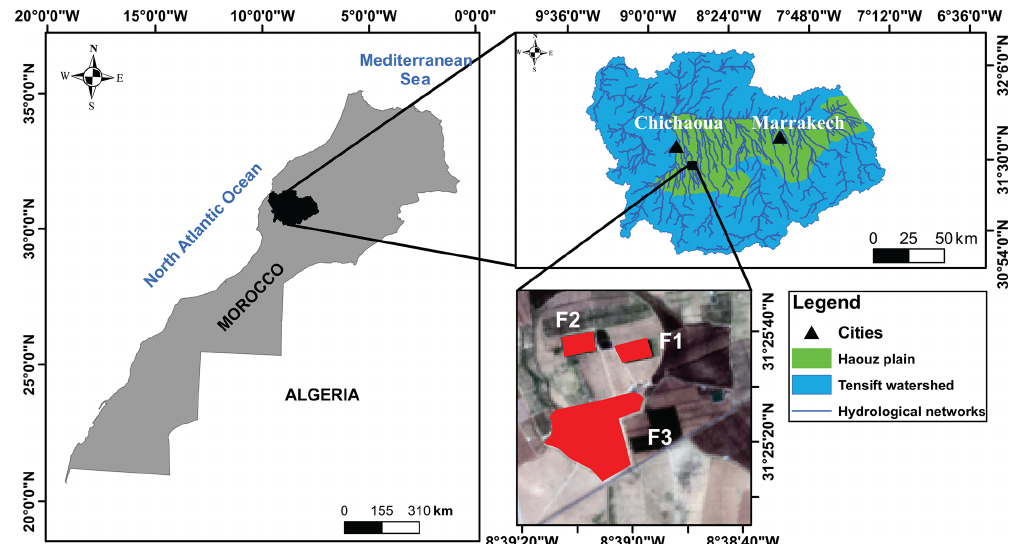
Figure 1. Location of the study fields: F1, F2 and F3 are drip-irrigated wheat plots in a private farm (Domaine Rafi) near the city of Chichaoua in the Haouz plain, central Morocco. Table 1. General information about the three fields. Field Area Season Sowing